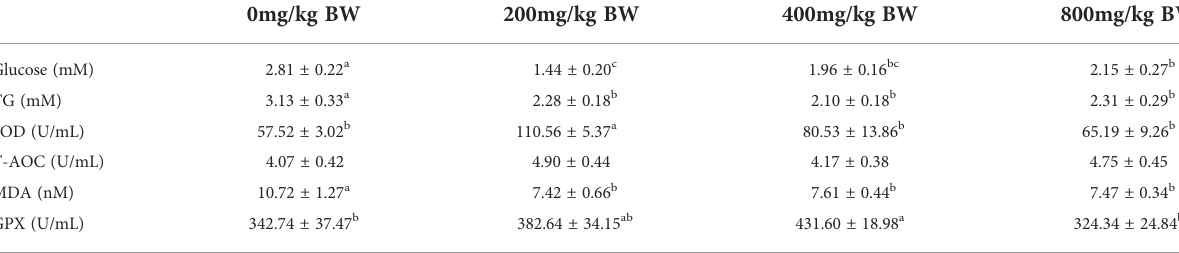
TABLE 3 Effects of tea polysaccharides on the plasma components of common